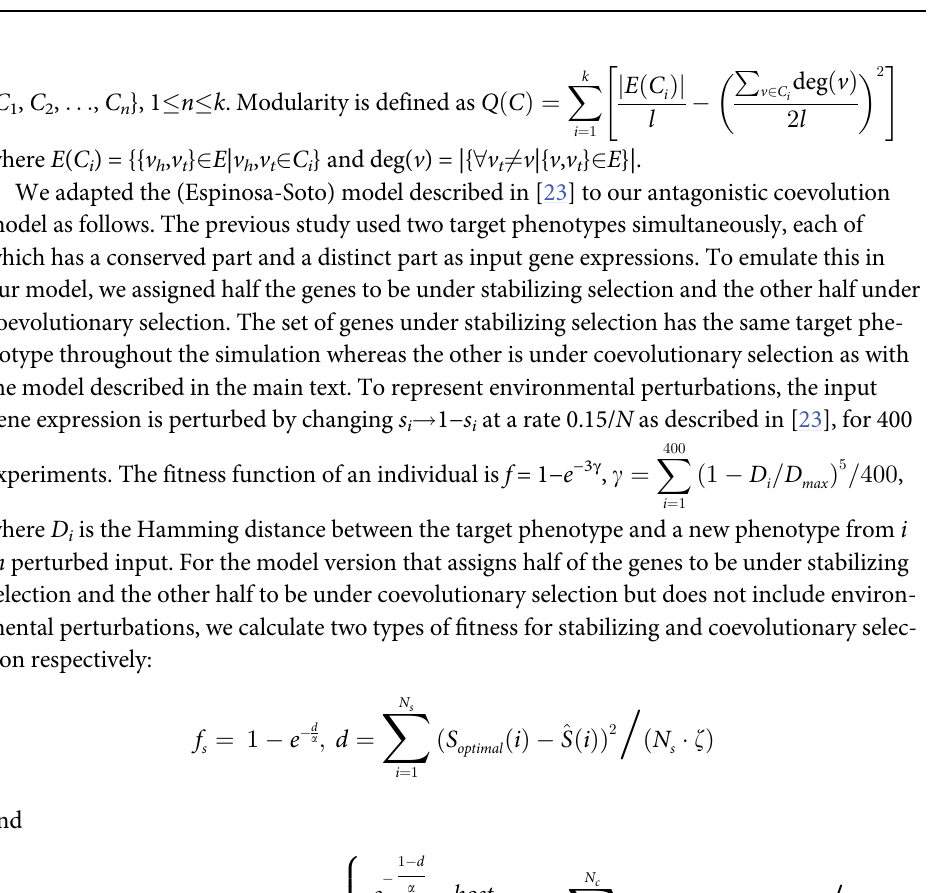
S3 Fig. Effect of parameter changes on the evolution of sensitivity and robustness.